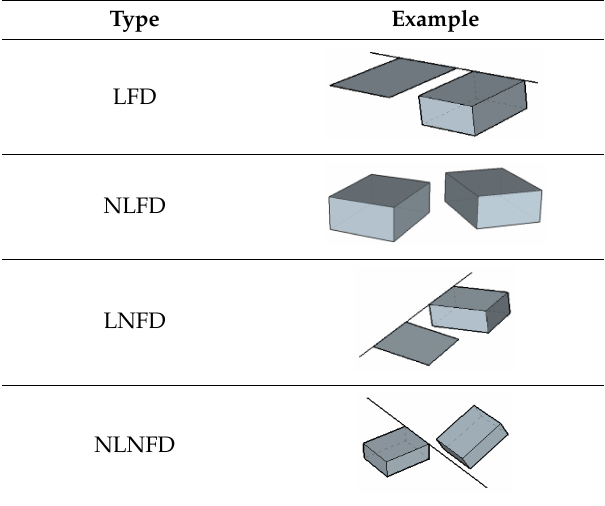
Table 2. The disjoint topological relation for objects in a 3-D cadaster.